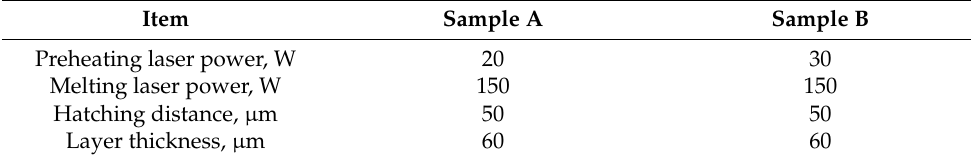
Table 5. The process parameters used to print different alumina samples.